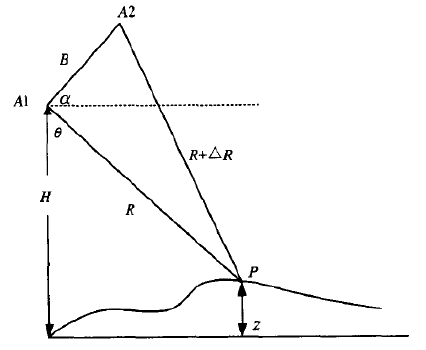
Figure 1. Figure of "Double track" method In the figure, A1 and A2 represent the positions of the two antennas respectively; B represent the distance between the antennas base line; the angle between the baseline and the horizontal direction is α; H is the height of the platform; θ is the reference line angle of the first sub antenna , terrain elevation is z.